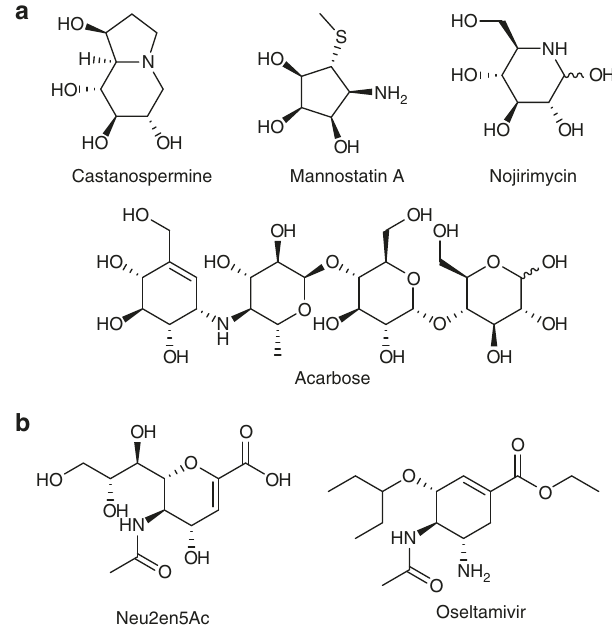
Fig. 1 Select competitive inhibitors of glycoside hydrolases. a Representative natural products. b Natural product (Neu2en5Ac) inspired therapeutic agent